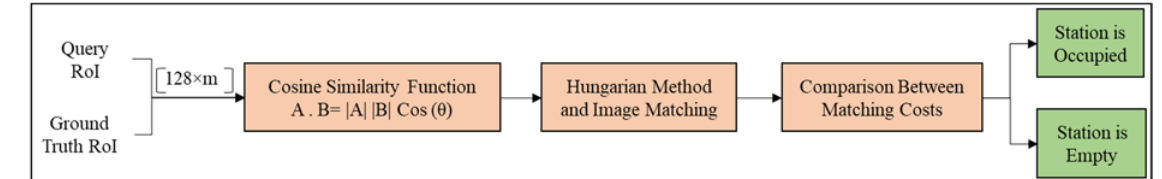
Figure 4. Image matching and occupancy identi fi cation pipeline.